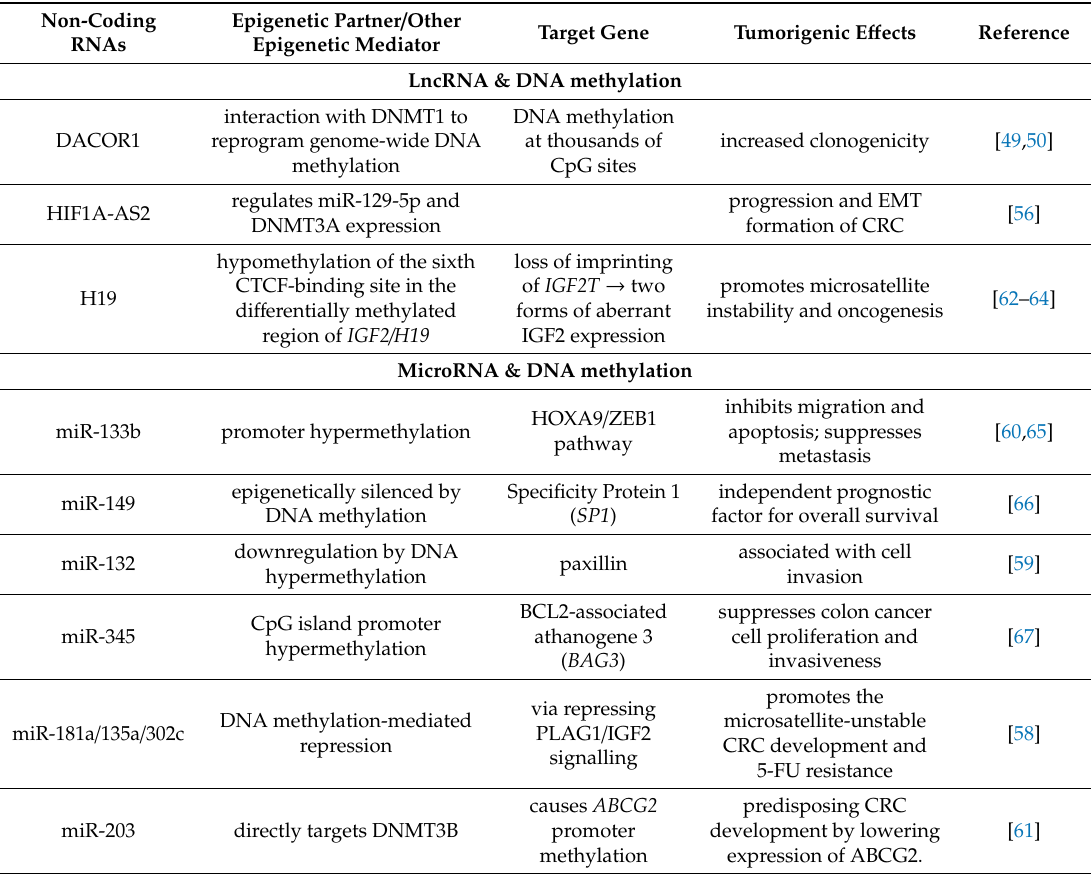
Table 1. Interplay of ncRNAs with DNA methylation in the pathogenesis of